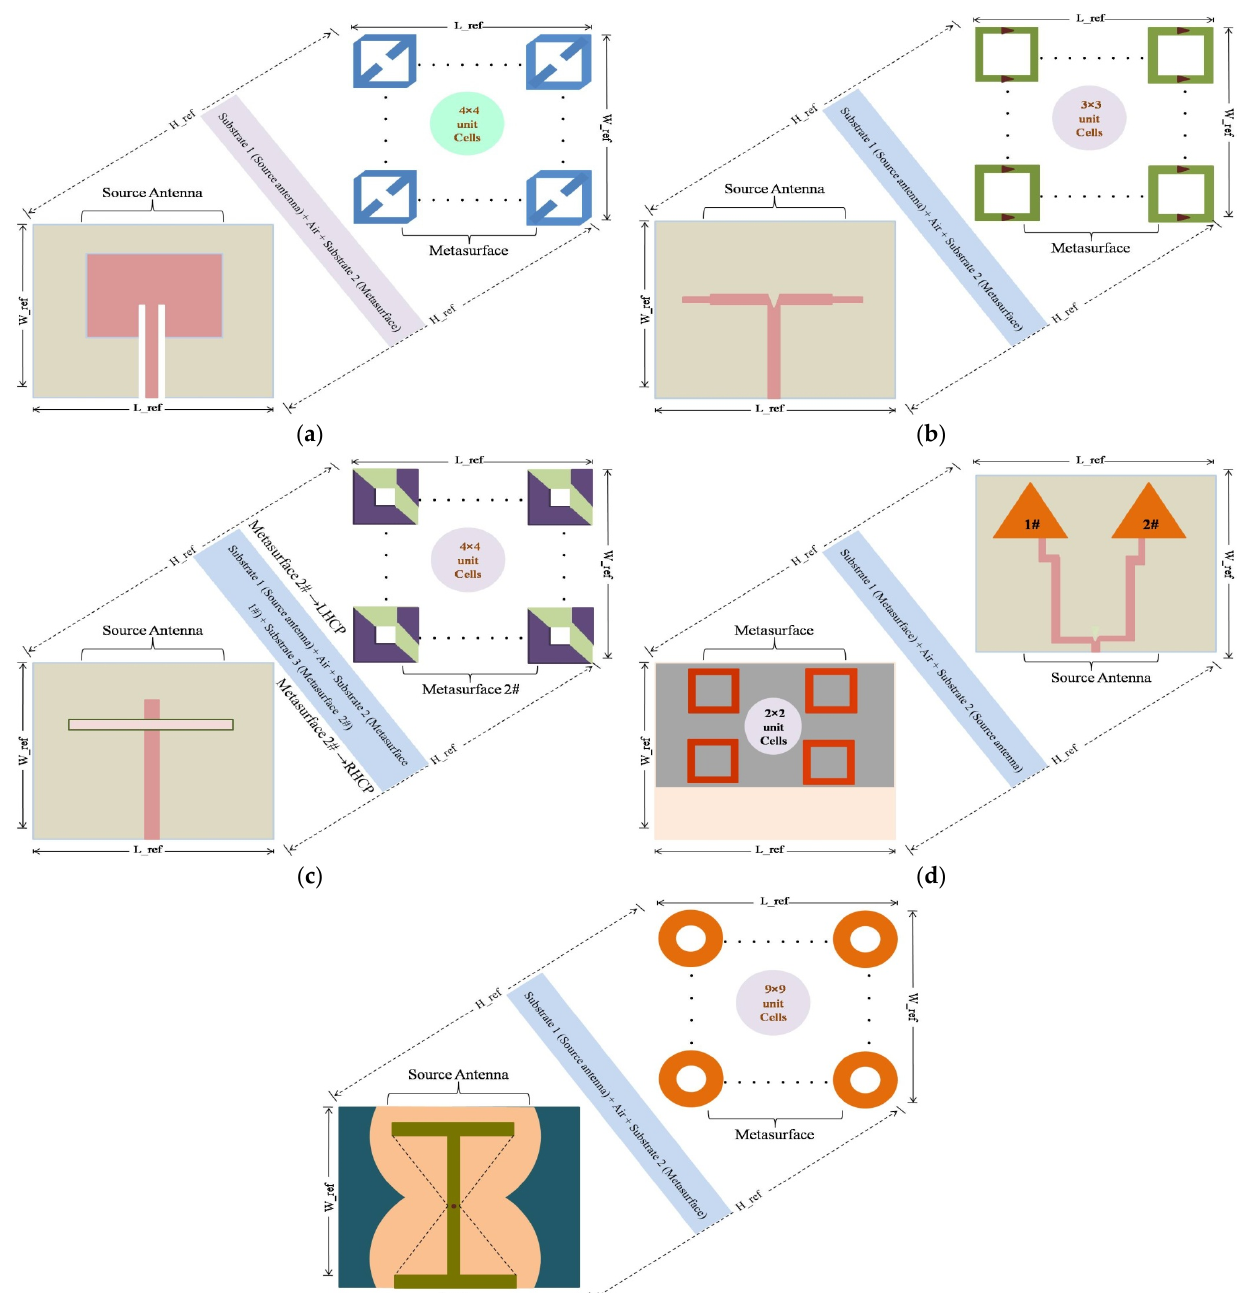
Figure 25. Candidate antennas with metasurface for CubeSats [20–24]: ( a ) S-band microstrip patch antenna with meta- surface [20]; ( b ) Controlled reconfigurable S-band antenna with metasurface [21]; ( c ) Microfluidic slotted patch antenna with metasurface [22]; ( d ) CP Reconfigurable monopole antenna with metasurface [23]; ( e ) S-band slot antenna with metasurface